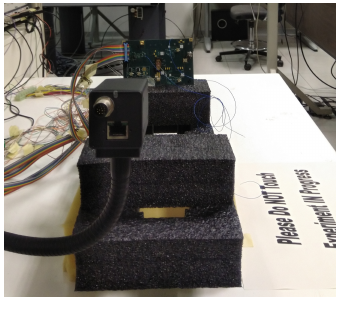
Figure 1. Experimental Setup.